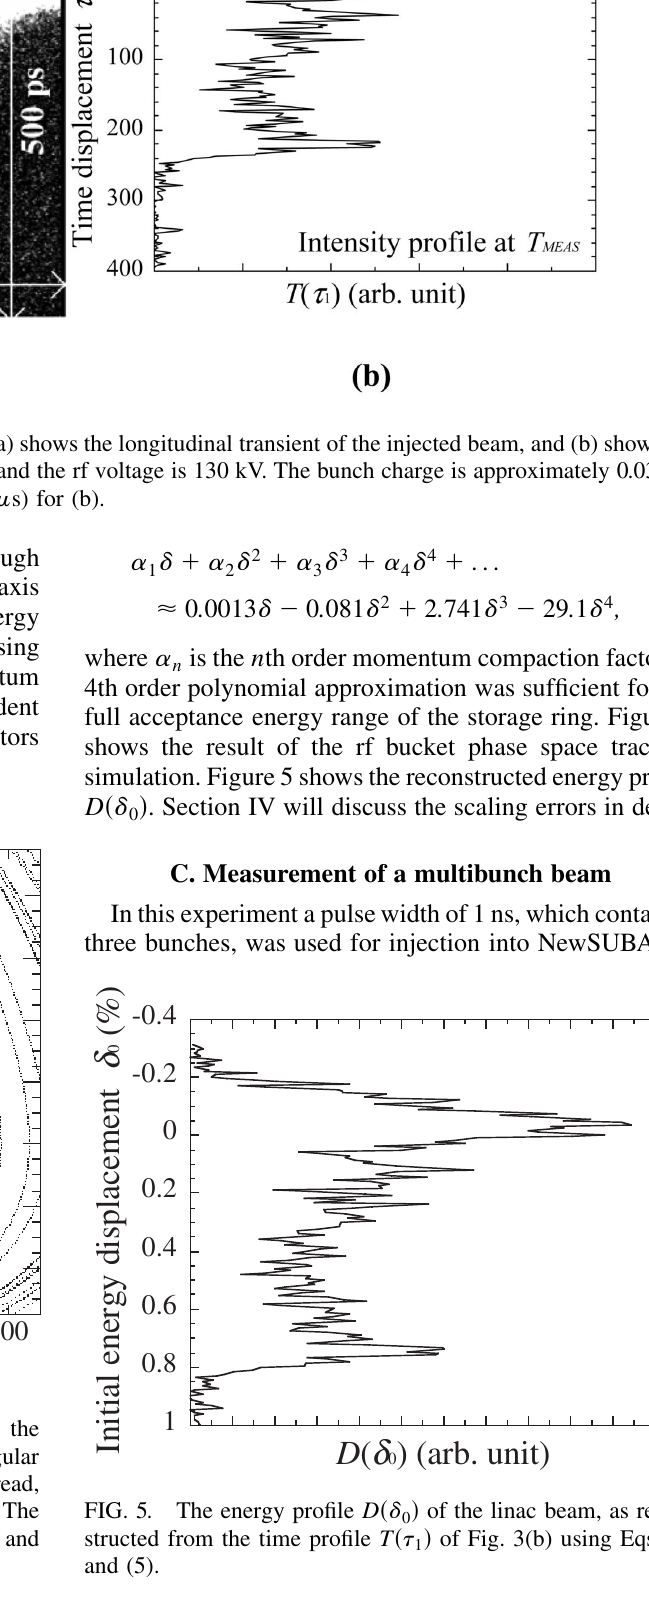
FIG. 5. The energy profile D (cid:4) (cid:3) structed from the time profile T (cid:4) (cid:1) and